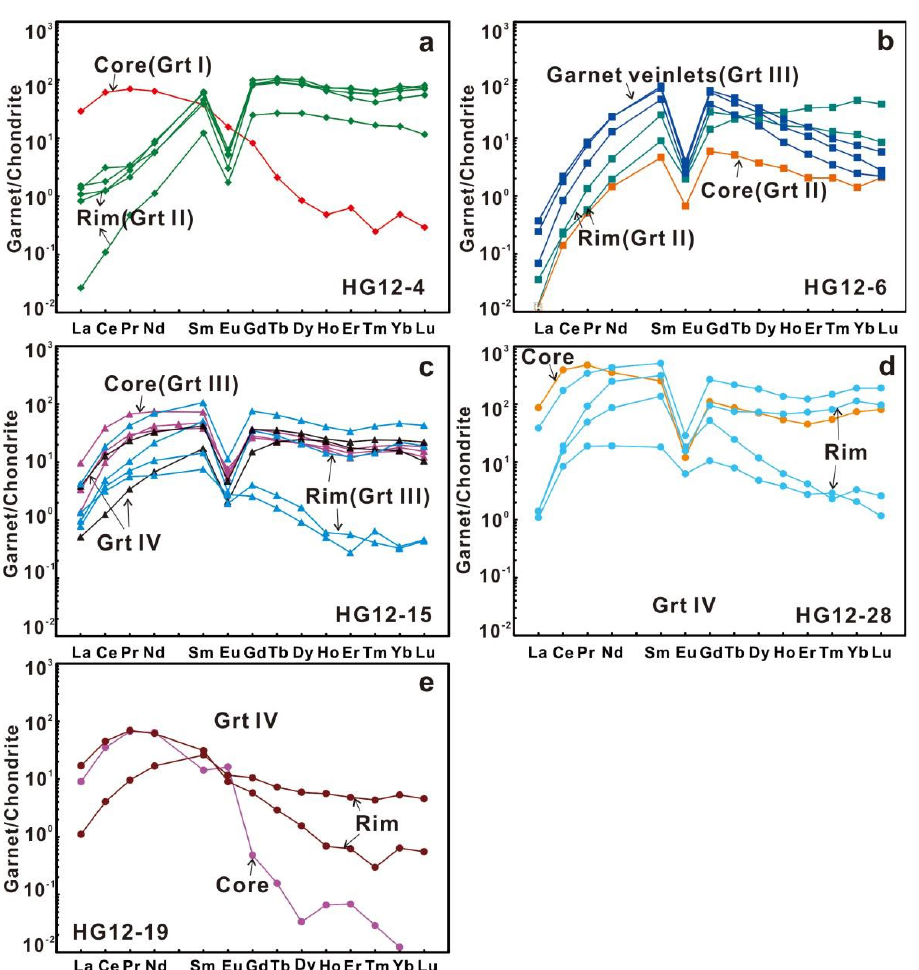
Figure 15. Chondrite-normalized REE patterns of the garnets from the Huanggang deposit. Samples were normalized to the C1 values of McDonough and Sun, 1995 [4 1 ].